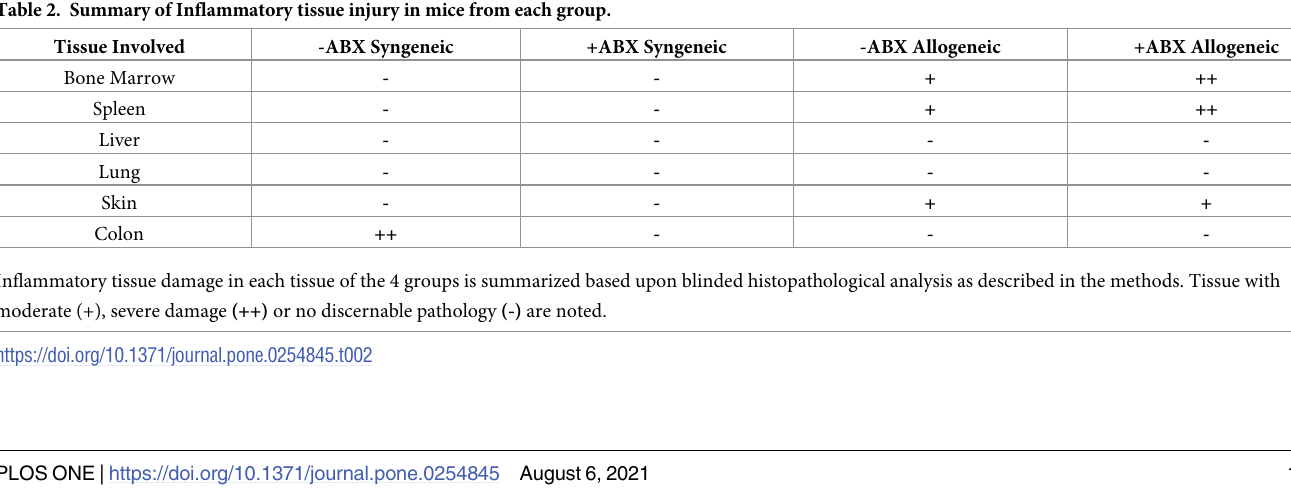
Table 2. Summary of Inflammatory tissue injury in mice from each group. Tissue Involved